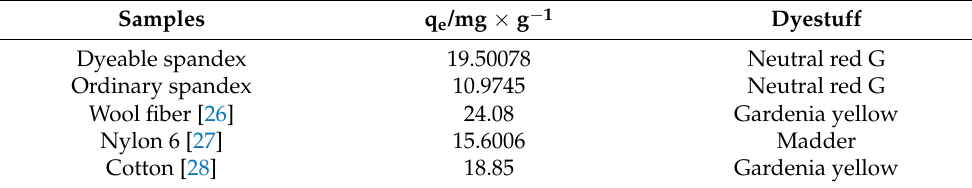
Table 2. Comparison of equilibrium adsorption capacity of different fibers.